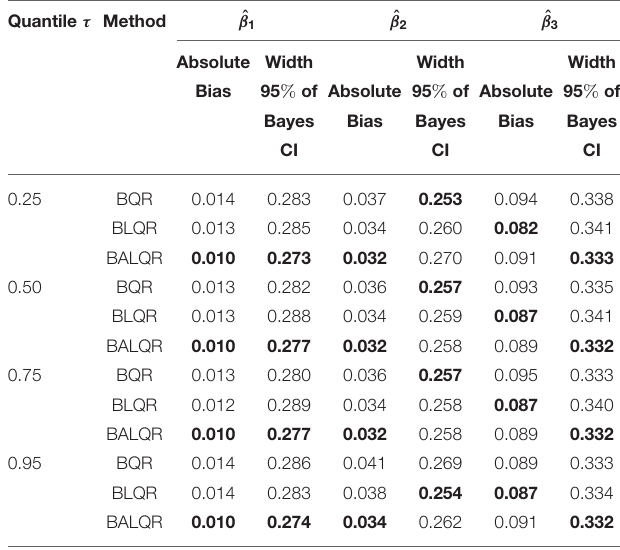
TABLE 1 | The bias and width of 95 % Bayes credible interval for heteroscedastic x 1 ) N (0,1)*. normal, e i (1 ∼ +